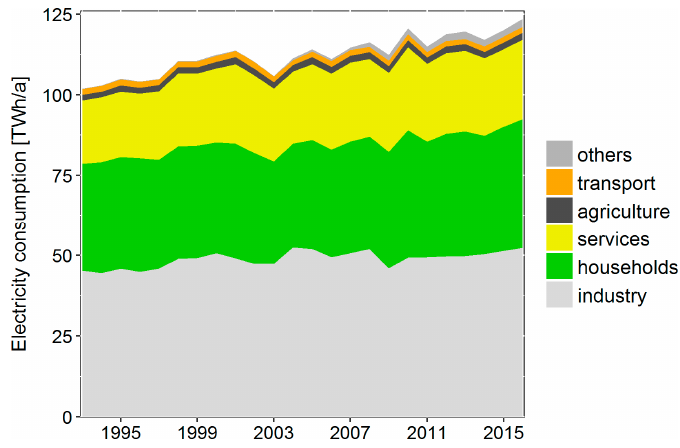
Figure 2. Electricity consumption, per sector, Norway, 1993–2016 [3].